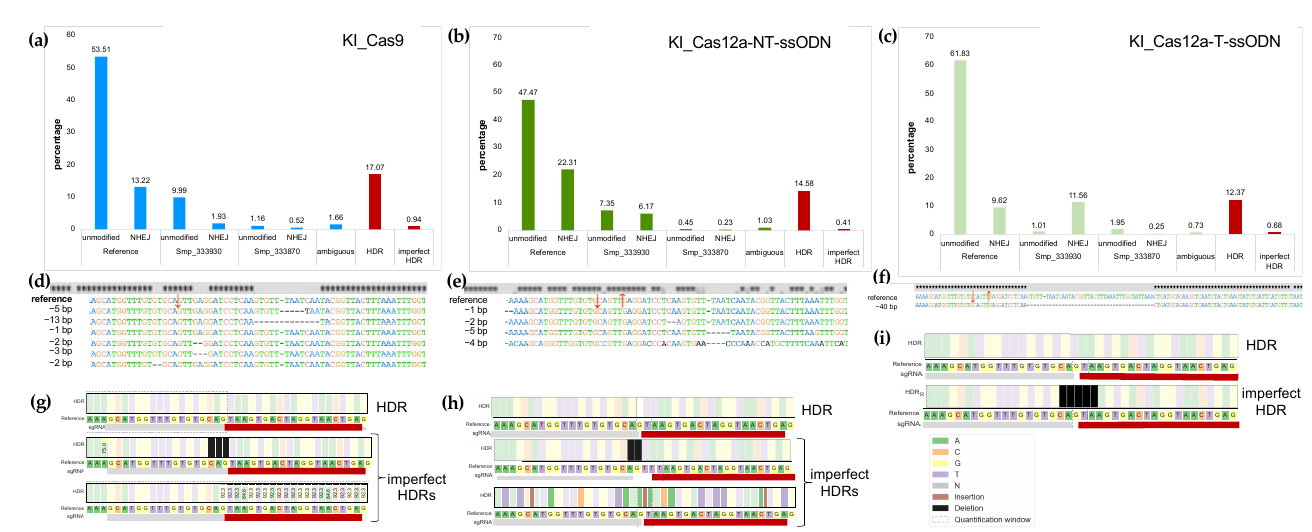
Figure 4. HDR and induction of NHEJ at the ω 1 target in the presence of donor ssODN templates: ( a – c ) show that the percentage of NHEJ from schistosome eggs that introduced RNP along with ssODN template were higher in the presence of ssODN donor templates than in their absence. There were totals of 15.67% (13.22 + 1.16 + 0.52), 28.71% (22.31 + 6.17 + 0.23), and 21.43% (9.62 + 11.56 + 0.25) editing efficiency in the KI_Cas9, KI_Cas12a_NT-ssODN, and KI-Cas12a_T-ssODN groups, respectively (blue or green bars in each graph); ( d – f ) Most mutations were substitutions and deletions located downstream of the programmed double-stranded breaks (DSB), with the DSBs indicated by red arrows; ( g – i ) A variety of sizes of base deletions from 1 to 15 bp in length were seen in the KI_Cas9, KI_Cas12a_NT-ssODN groups while large deletions, up to 40 bp, were evident as major deletions detected in the KI_Cas12a_T-ssODN group. The percentage of perfect HDR in the three experimental groups, KI_Cas9, KI_Cas12a_NT-ssODN, and KI_Cas12a_T-ssODN were 17.07%, 14.58%, and 12.37%, respectively (red bars). In addition, imperfect HDRs occurred in all KI treatment groups, likely as the result of interruption of 5 (cid:48) end HDR gene repair by competing NHEJ activity with the result that deletion of 2–5 nt were seen along with donor transgene insertion (black bars in panels g , h , i ); the frequency of this event was 0.94, 0.41, and 0.68% among the KI_Cas9, KI_Cas12a_NT-ssODN, and KI_Cas12a_T-ssODN